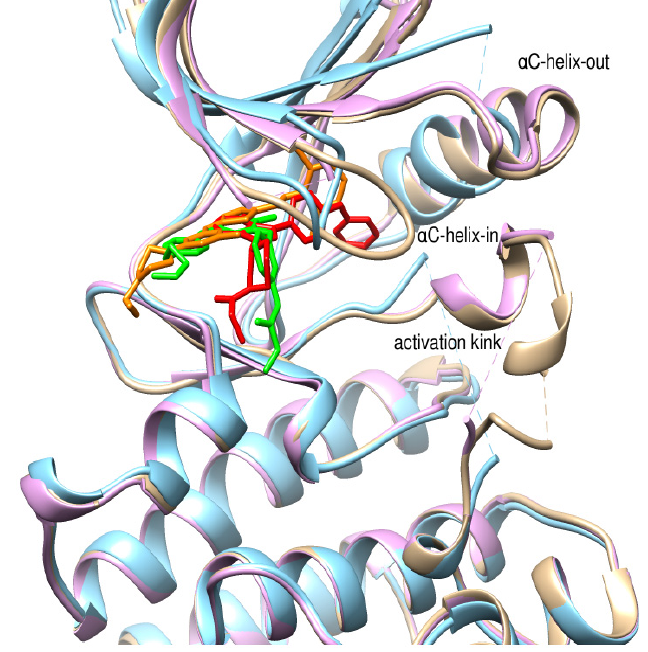
Figure 5. Overlay of BTK kinase domain bound to ibrutinib (5P9J), dasatinib (3K54), and CC92 (5P9L). Protein: grey-ibrutinib-bound, blue-dasatinib-bound, purple-CC292-bound. Ligands: red-ibrutinib, yellow-dasatinib, green-CC292. Ibrutinib and dasatinib interact in an extended conformation and occupy the posterior cleft in the catalytic site. CC292 acquires a U-shape and occupies the anterior cleft in the catalytic site. Dasatinib binding results in an α C-helix-in conformation, while ibrutinib and CC292 stabilize α C-helix-out conformation. Dasatinib-bound BTK did not display the activation